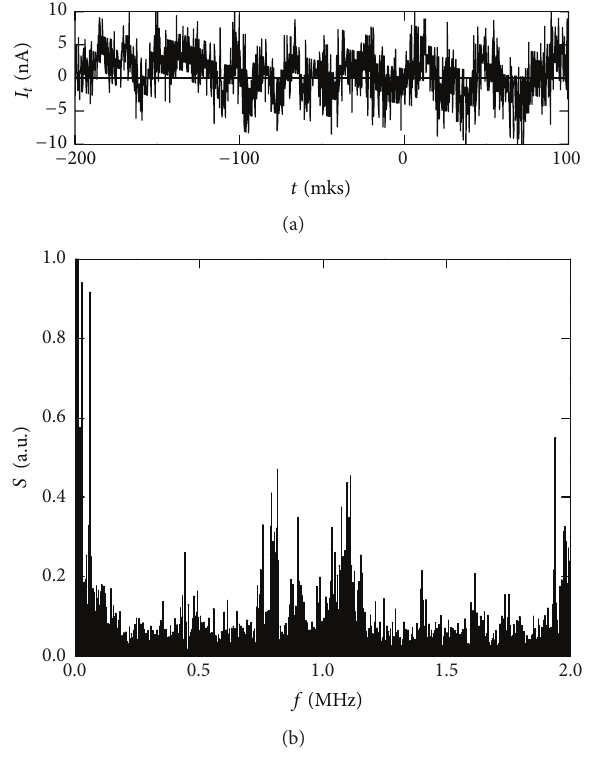
Figure 4: A waveform (a) and the power spectrum (b) of noise signal generated during the resistive switching in AFM probe contact to the YSZ/Si